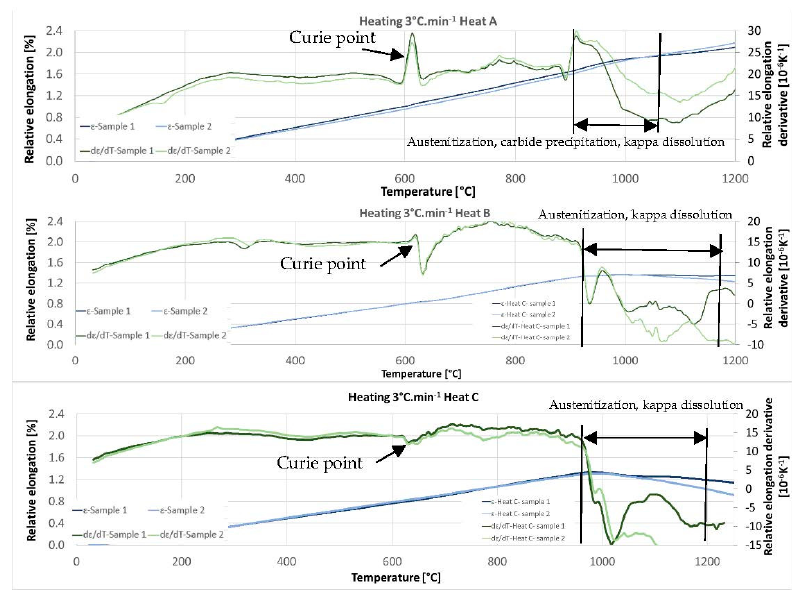
Figure 11. Dilatometric curve—heating 3 °C/min.